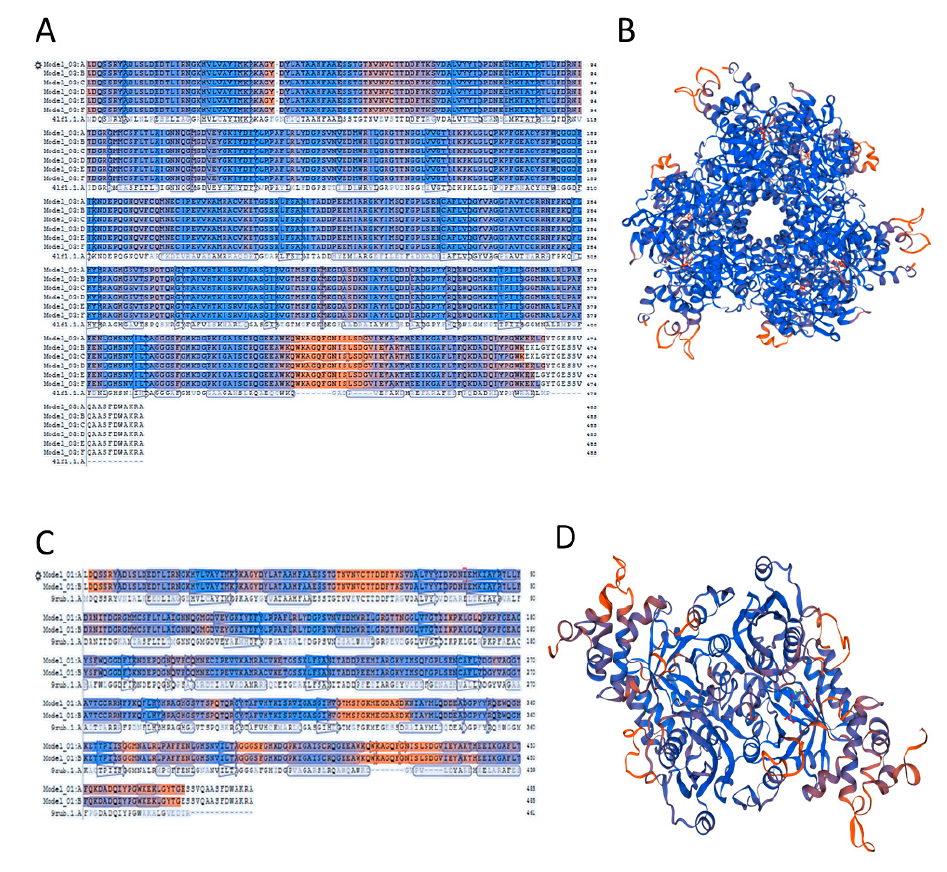
Figure 2. Models’ template alignment ( A , C ) and structures ( B , D ) of Symbiodinium sp. Rubisco based on the 5.hgm.1A structure of form II Rubisco from R. palustris ( A , B ) and 9.rub1A from R. rubrum ( C , D ). Figures generated by SWISS-MODEL. Red colour indicates poorly modelled regions.